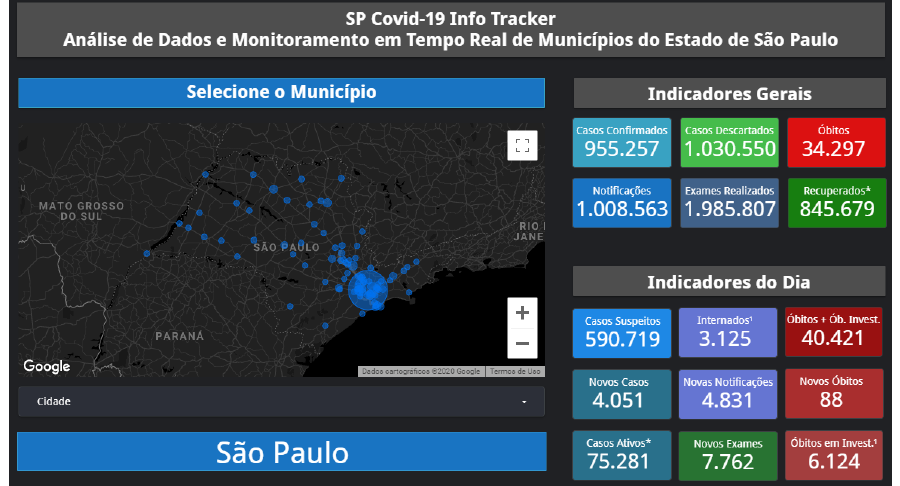
Figure A1. SP Covid-19 Info Tracker Platform (http://www.spcovid.net.br): First page view.